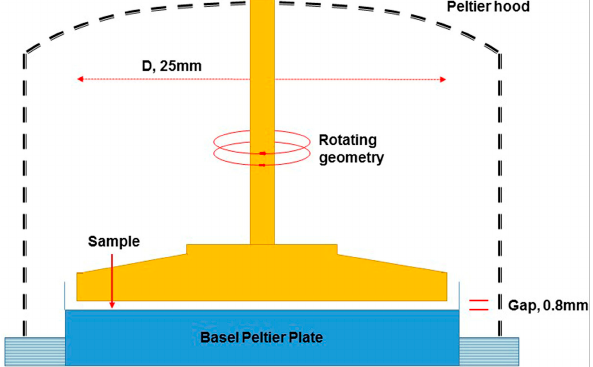
Figure 1. Schematic diagram of the rheometer and its plate-plate measuring system.